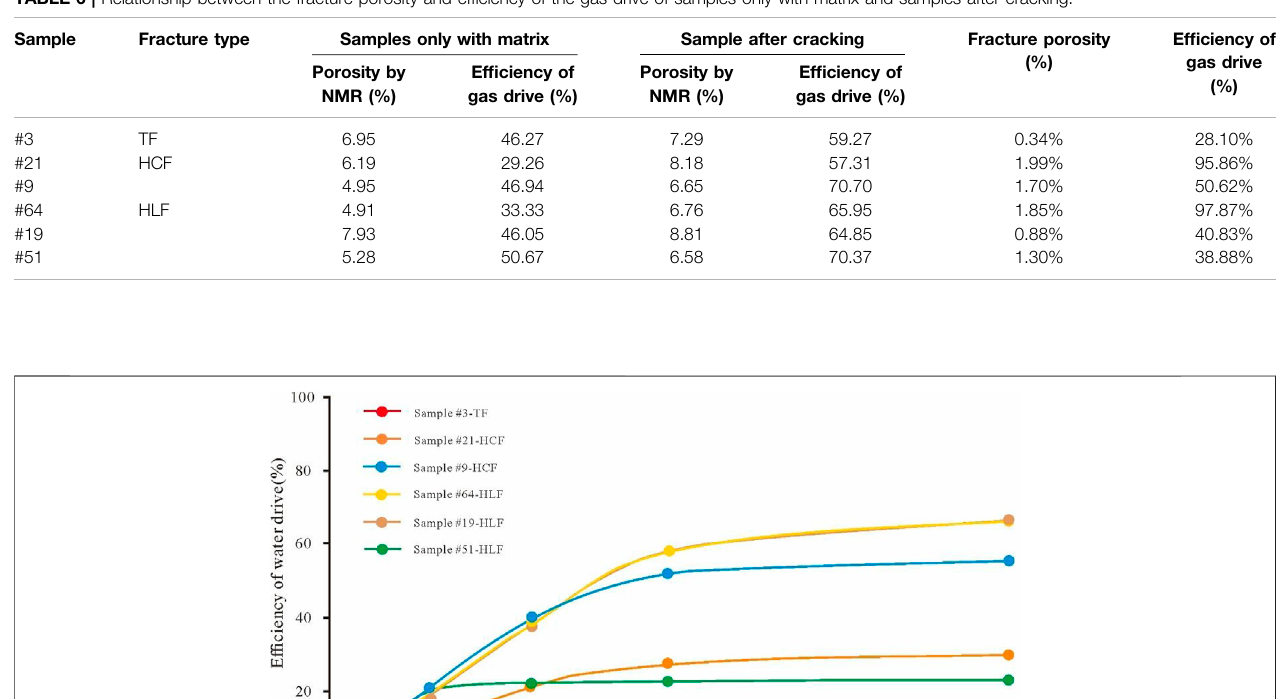
TABLE 6 | Relationship between the fracture porosity and ef fi ciency of the gas drive of samples only with matrix and samples after cracking.